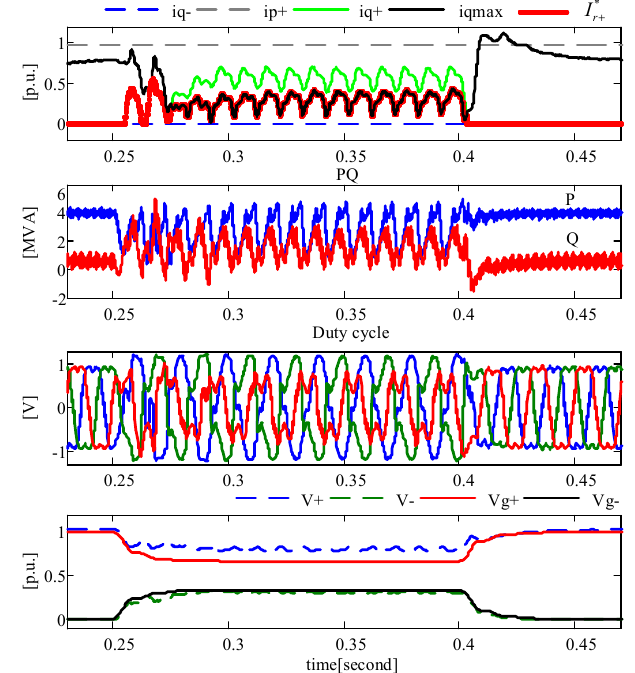
Figure 19. Voltage faults: 1ph 100% voltage sag without injecting negative sequence current with anti-saturation for SCR = 2. From top to bottom: in first figure active current reference, reactive current reference and the maximum available reactive current reference; in second figure active and reactive output power of converter; in third figure duty cycle; and in fourth figure magnitude of positive and negative sequence of PCC voltage and grid voltage.